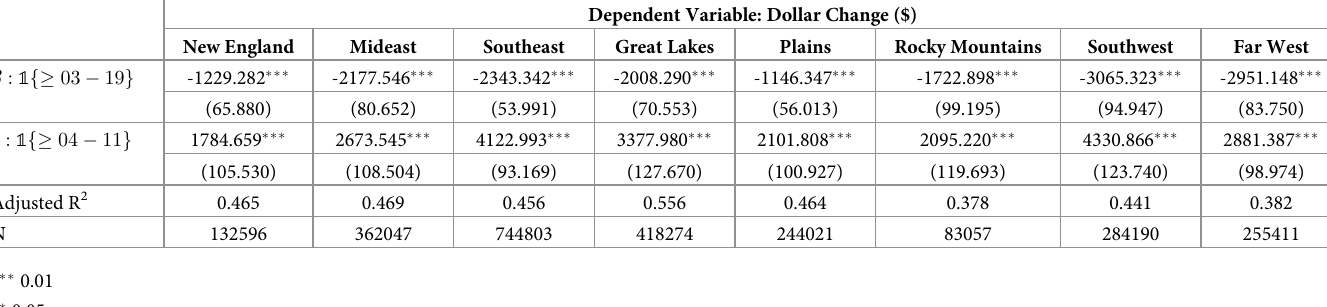
Table 3. Effects of initial lockdown and stimulus payments on dollar change across geographic